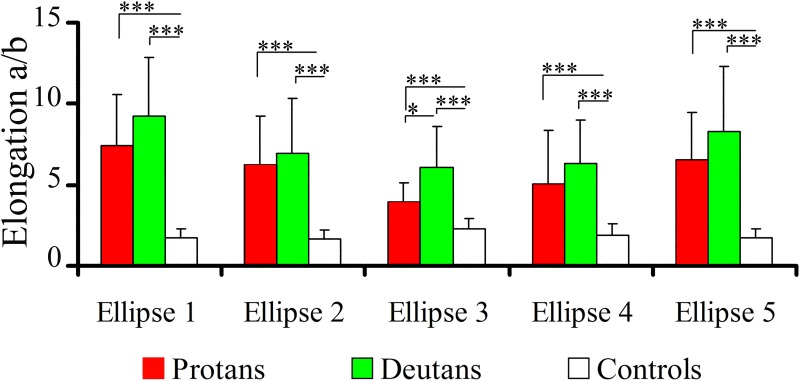
Statistical comparisons of results obtained in the MR test: elongations of the Mollon-Reffin ellipses.Comparisons between the elongations of colour discrimination ellipses for protans, deutans, and controls. Both protans and deutans had ellipses significantly more elongated than controls. There were no statistical differences between protans and deutans, except for Ellipse #3. Significant differences: *p = 0.05; ***p < 0.0001; Kruskal-Wallis.